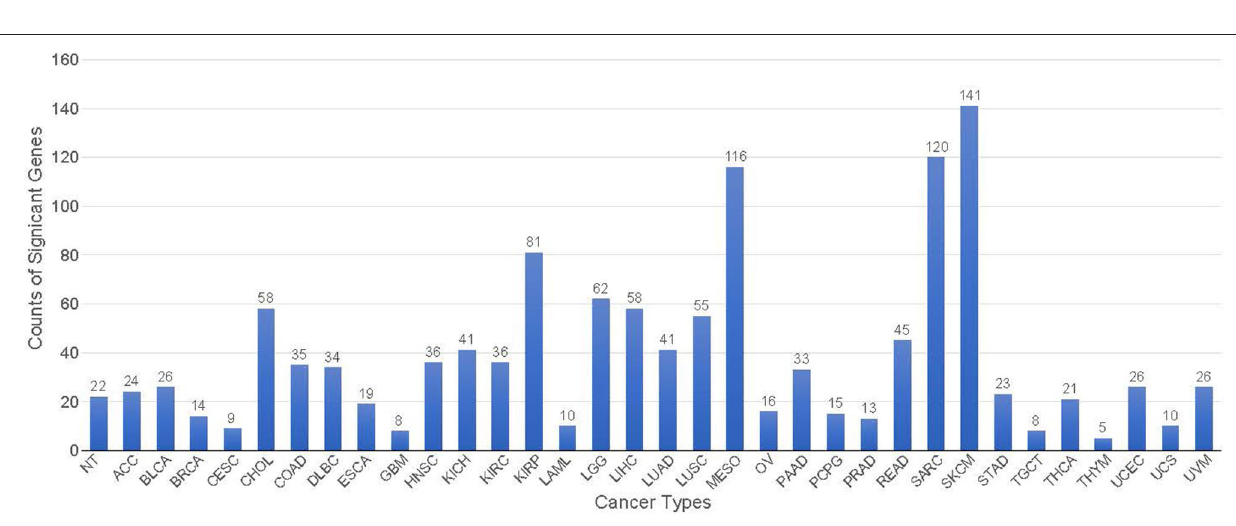
FIGURE 9 | The number of genes significantly affect each cancer type classification with a gene-effect score >